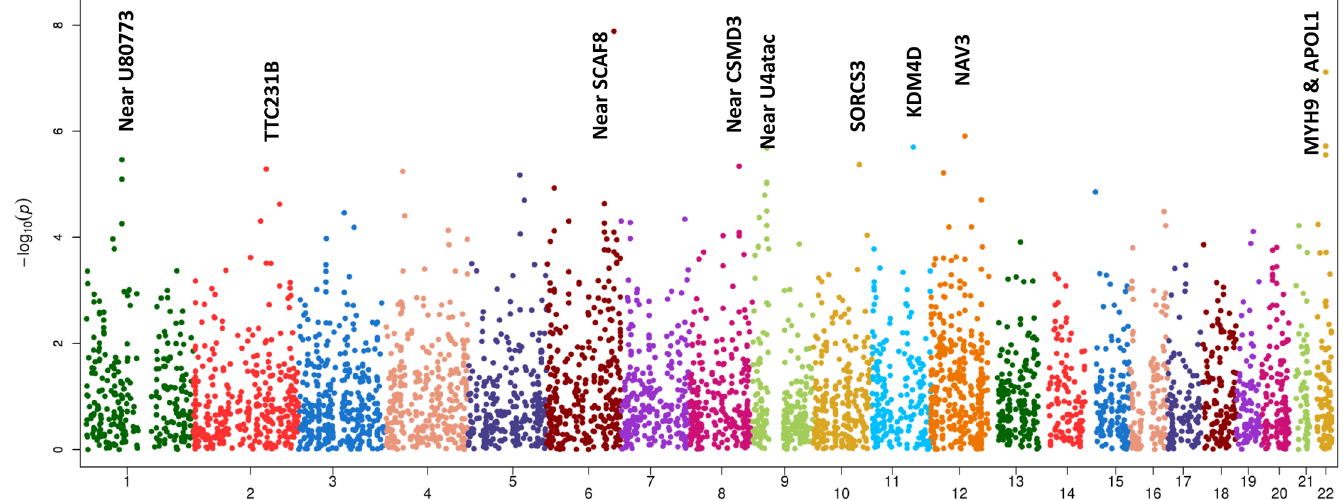
Fig 1. Manhattan plot of FIND GWAS meta-analysis associations across ancestries included in Discovery and Replication samples.